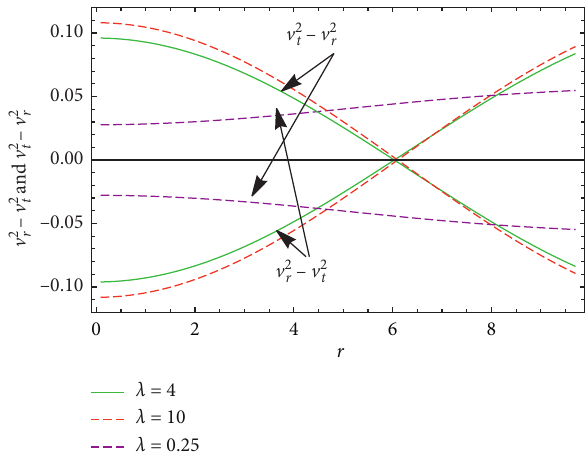
− v 2 v 2 − v 2 � 0 . 25, 4, t r and r t for λ